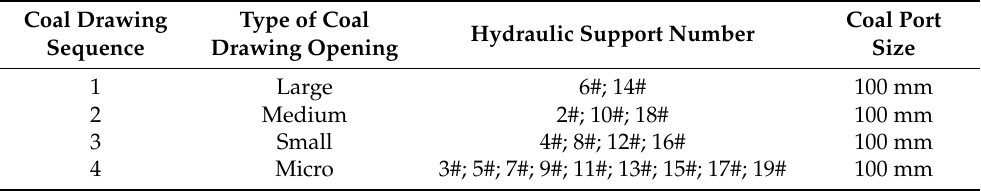
Table 5. The coal drawing sequence of similar simulation.